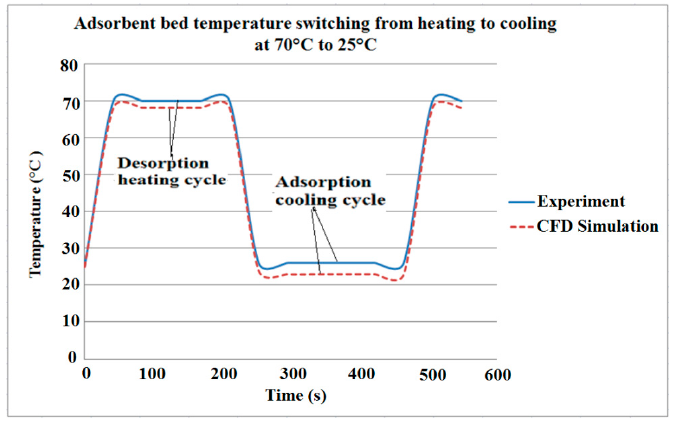
Figure 27. Comparison of the outlet temperature of the CFD simulation and the experiment data by J. White ©2012 [10].